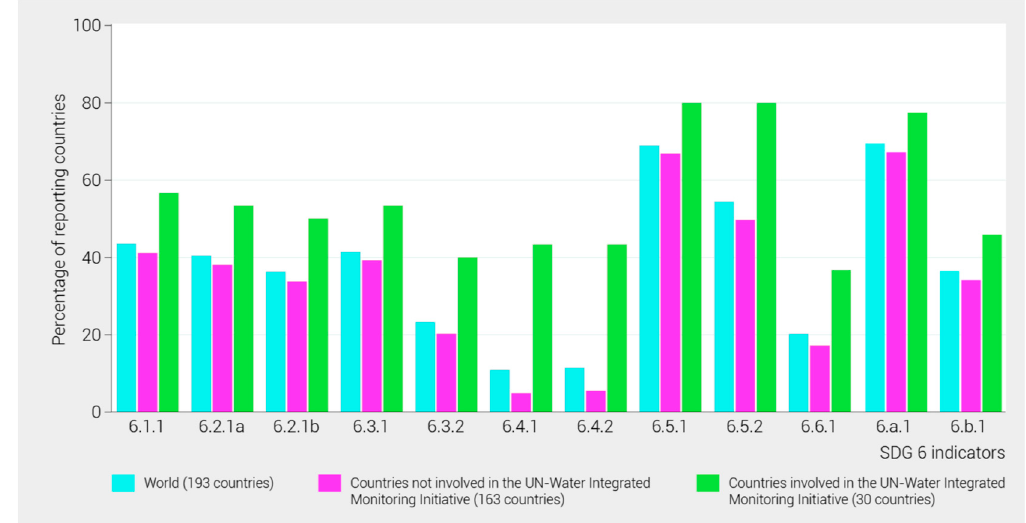
Figure 2. Proportion of countries reporting on SDG 6 indicators 2016–2018. Source: [1].